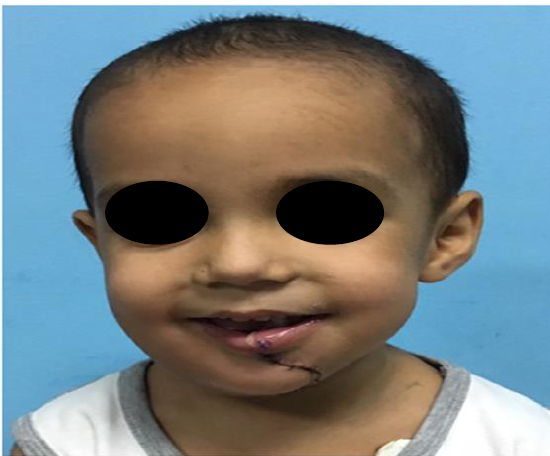
Fig. 6. Postoperative evolution of the patient after seven